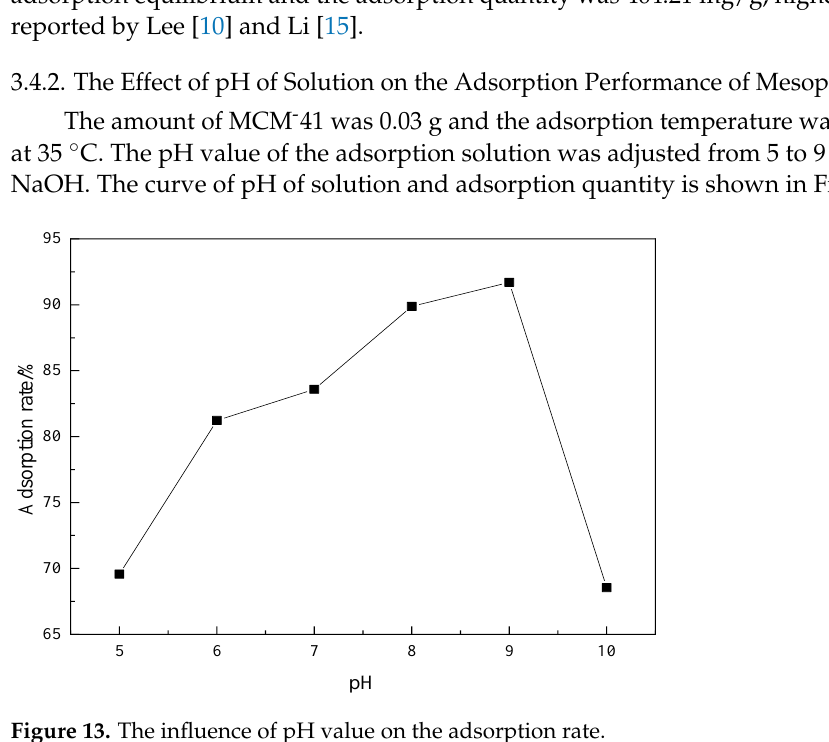
Figure 13. The influence of pH value on the adsorption rate.